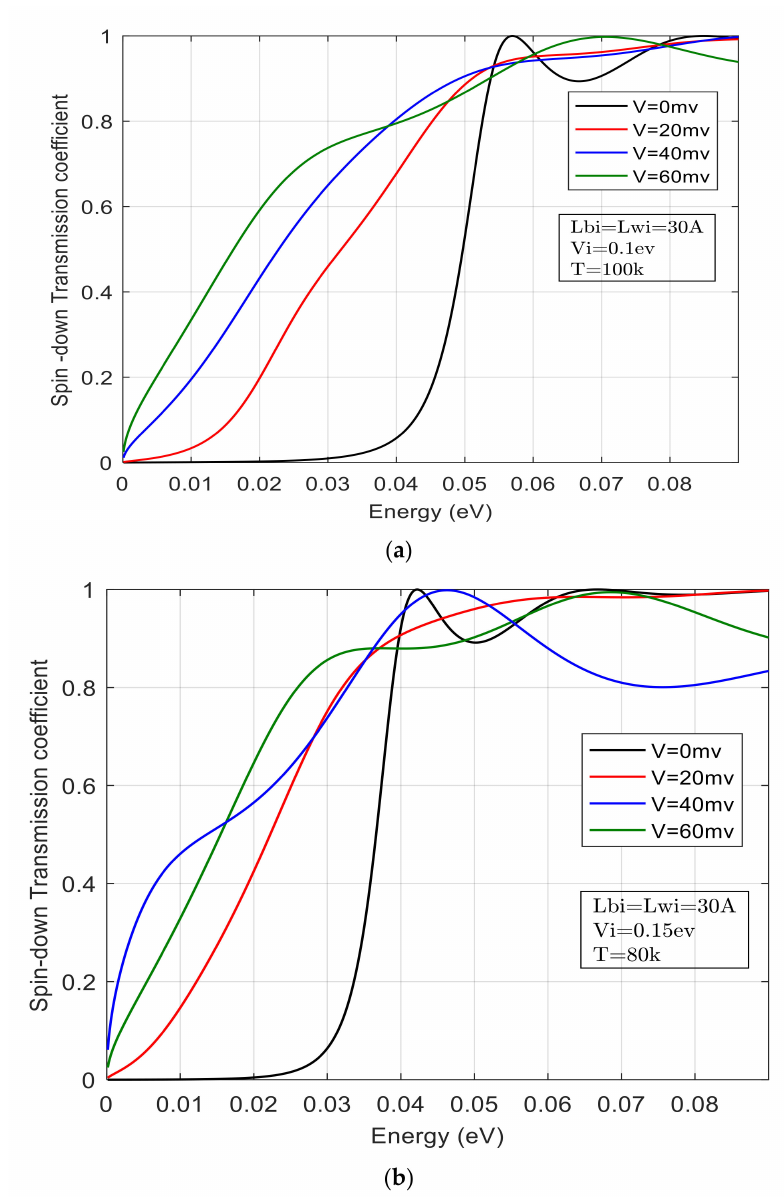
Figure 10. ( a ): The transmission coefficient of spin-down holes as a function of incident energy for different applied bias voltages (N = 5 and T = 100 K). ( b ): The transmission coefficient of spin-down holes as a function of incident energy for different applied bias voltages (N = 5 and T = 80